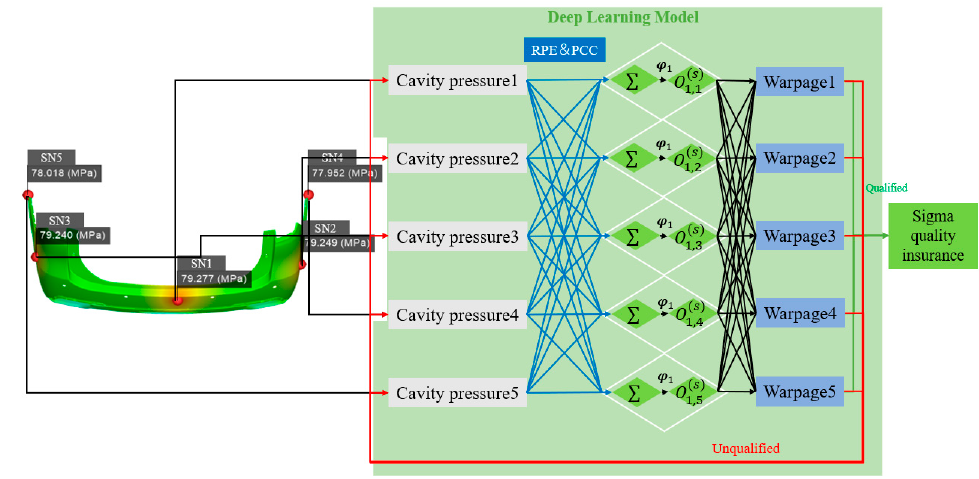
Figure 6. A simple diagram of predictive control applying a deep network model in this study.